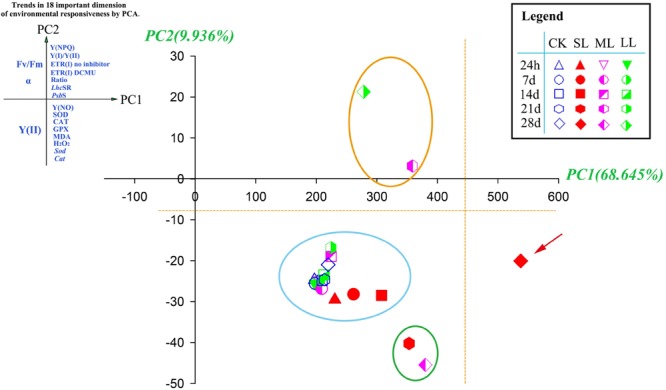
Principal components analysis (PCA) of 18 photosynthetic and antioxidant responses in CK, SL, ML, and LL thalli of U. prolifera. Plant responses associate with the first two dimensions (Table 4) are grouped at the end of each principal component, PC1 (x-axis) and PC2 (y-axis). Ratio: ETR(I) DCMU/ETR(I) no inhibitor.